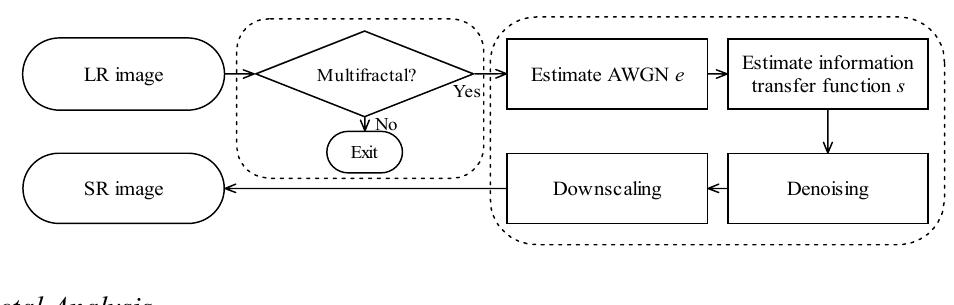
Figure 2. Framework of SR